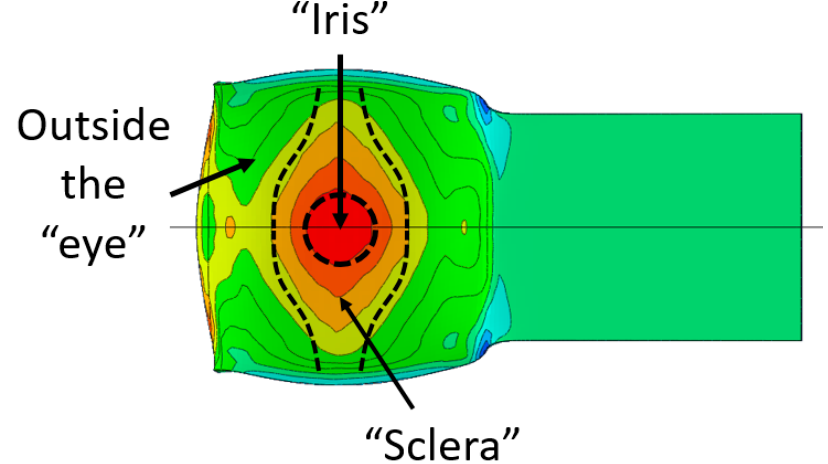
Figure 8. Areas of interest where the different values of bonding quality parameter J where computed.